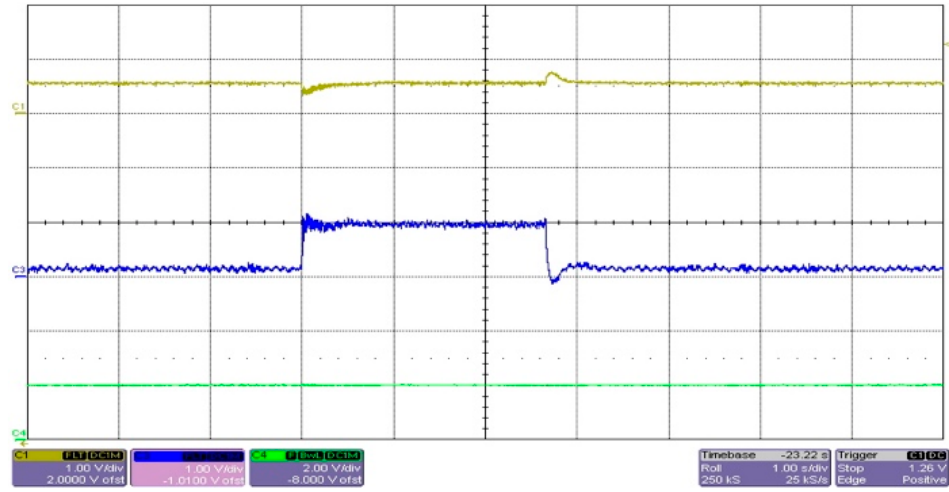
Figure 13. Experimental result: current sensorless control using estimated stator currents when all current sensors fail. Measured rotor speed (yellow), torque (blue) and flux (green) producing stator currents—step changes of load torque from 0 to 3 Nm at 50 rpm. Scales: speeds—100 rpm/div; currents—1 A/V; time—1 s/div.